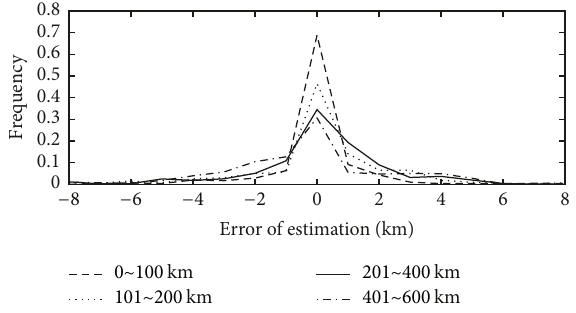
Figure 10: The probability density functions of differences between the estimated and observed CBHs.